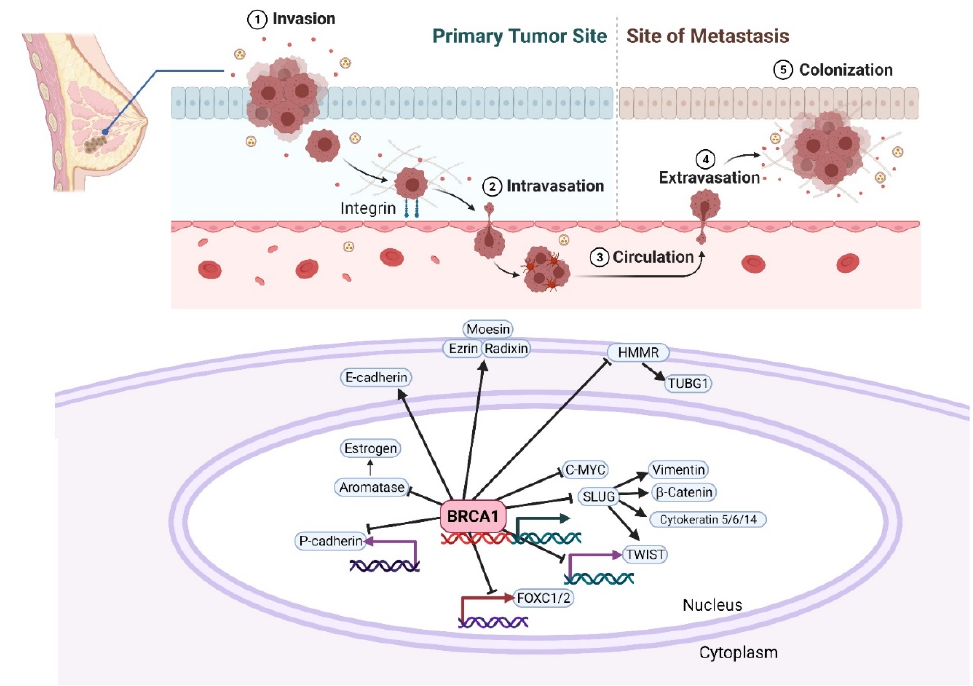
Figure 2. A schematic of the possible effects of BRCA1 on cancer initiation and metastasis. The different stages leading to metastasis are indicated. Several reports have directly or indirectly implicated BRCA1 in the regulation of EMT-promoting factors. BRCA1 mutations in breast cancer cells lead to enhanced EMT phenotype by upregulating key transcription factors like FOXC1/2, TWIST, and SLUG, and by modulating the expression of P-cadherin, cytoskeletal markers, Vimentin, and β -catenin. Breast cancer-associated mutations at the amino-terminus of BRCA1 abolish its ubiquitin ligase activity and abrogate its intracellular colocalization with ERM (Ezrin-Radixin-Moesin) and F-actin, leading to spontaneous motility of human breast cancer cells. Created with Biorender.com.